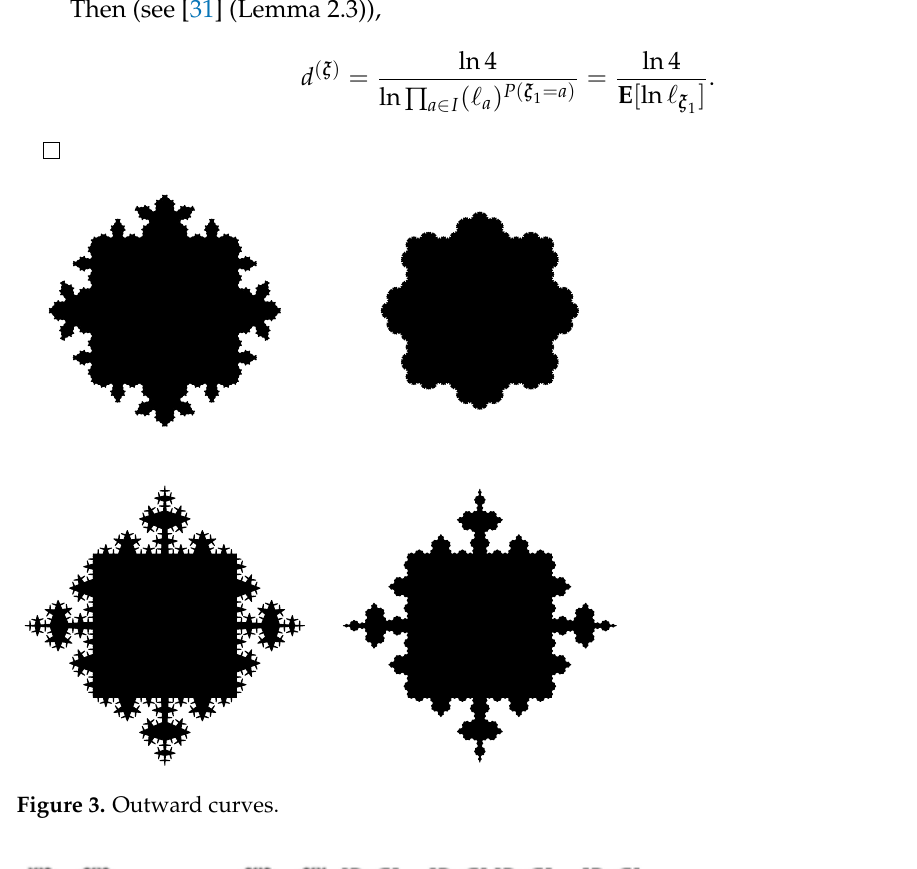
Figure 3. Outward curves.